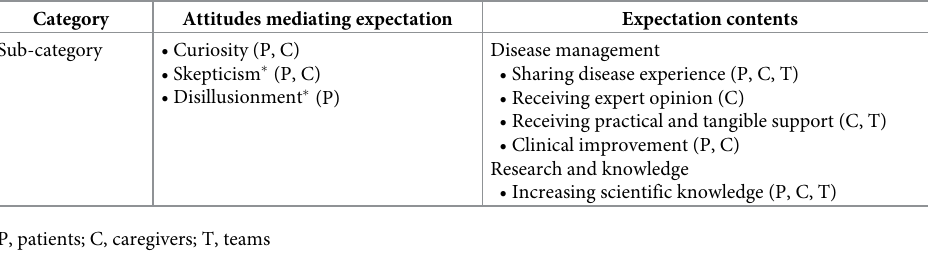
Table 3. The two expectation categories (columns) and eight sub-categories (rows) reported by participants.